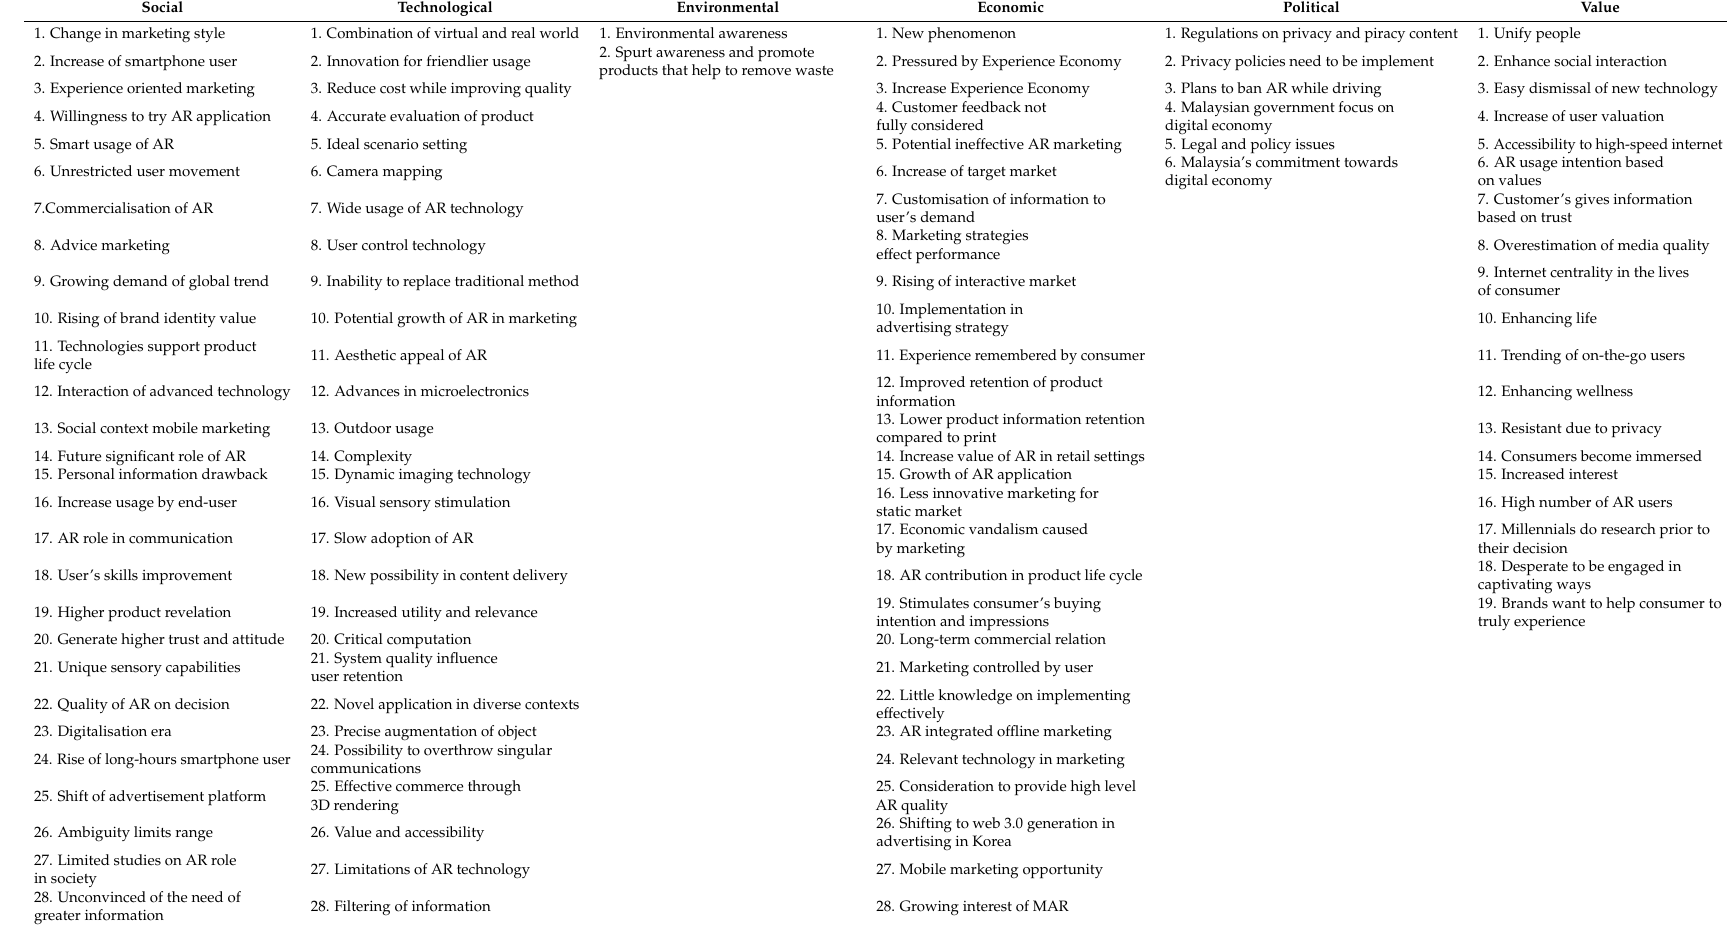
Table A1. Key issues and drivers of AR